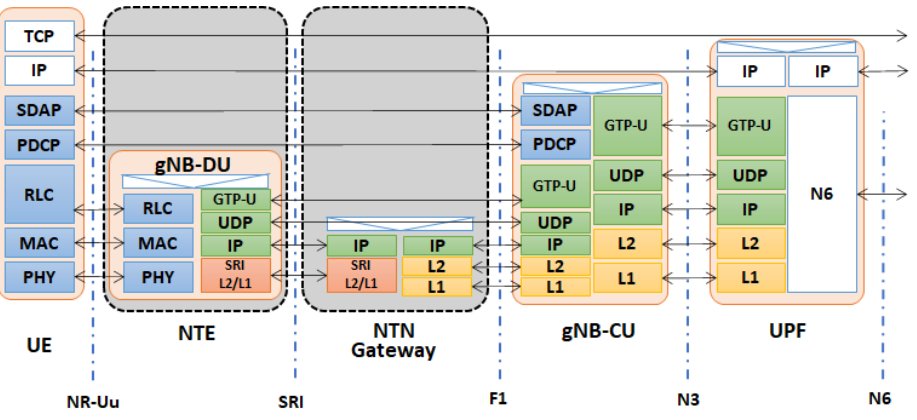
Figure 9. Protocol stack of the user plane in the NTN architecture with on-board distributed unit